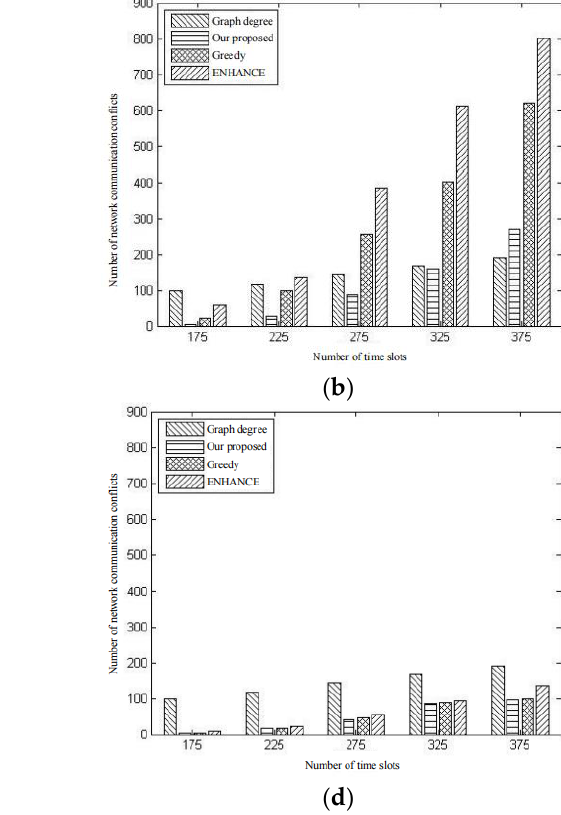
( b ) Figure 13. Network throughput with different channel numbers. ( a ) Channel number: 3, ( b ) Channel number: 12. Therefore, it is still a low network throughput. With the addition of nodes, the trans- mission delay becomes longer. However, nodes that are sent successfully in each time slot are rapidly increasing, leading to gradually improved network throughput. Because of the fixed number of distributable time slots, when nodes keep being added, there is an increase in signal conflicts but a gradual decrease in network throughput. By reading Fig- ure 13, it can be seen that when the channel number is 3 and the number of nodes is around 180, the network throughput of this algorithm reaches the maximum (0.18); when the channel number is 12 and the number of nodes is in the range of 100 to 200, the network throughput of this algorithm is more than 0.18. Therefore, it can be concluded that as the number of nodes reduces, the indirect conflict is the major factor limiting network throughput, and direct conflict has a greater impact on network throughput as the number